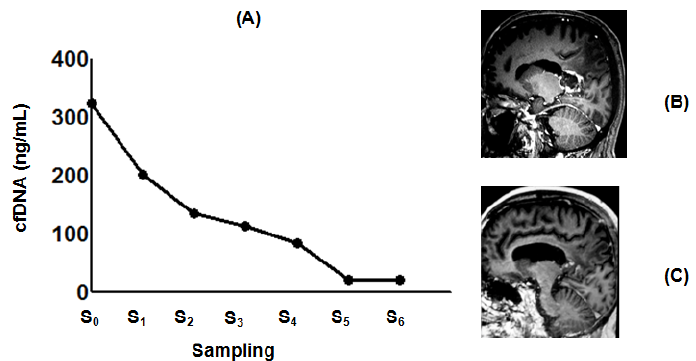
Figure 4. Figure of a GBM patient with a complete response to ITN-POH treatment. MRI at the time of protocol inclusion ( B ) corresponded to high cfDNA levels ( A , S 0 = 323 ng/mL, February 2008). ITN-POH therapy caused a consistent sharp reduction of cfDNA serum levels ( A , S 1 = 201 ng/mL, March 2009; S 2 = 135 ng/mL, June 2010; S 3 = 113 ng/mL, September 2011; S 4 = 85 ng/mL, March 2012). Continuous ITN-POH therapy caused a 16-fold reduction of cfDNA levels after 6 years. ( A , S 5 = 20 ng/mL, February 2013; S 6 = 20 ng/mL, July 2014) which was compatible with no detectable brain MRI lesion ( C ).